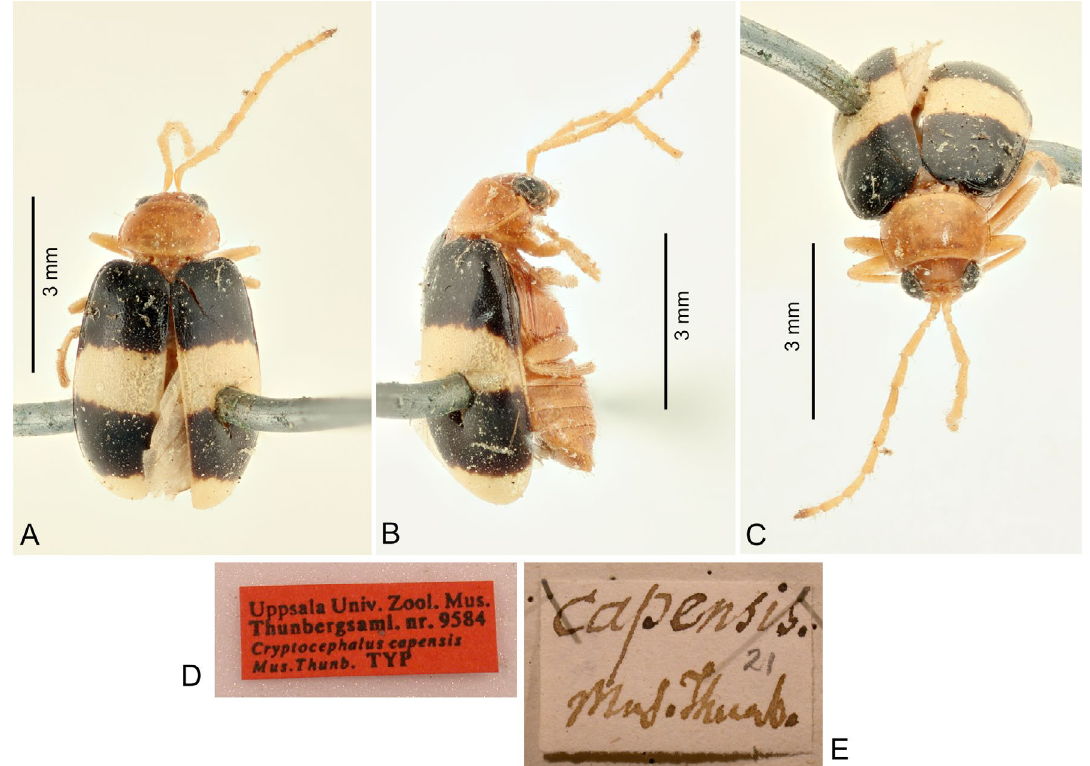
Fig. 16. A–E . Monolepta melanogaster (Wiedemann, 1823) (syntype of Cryptocephalus capensis Thunberg, 1827, ♂, 5.0 mm, UUZM). A . Dorsal view. B . Lateral view. C . Frontal view. D . Label. E . Box